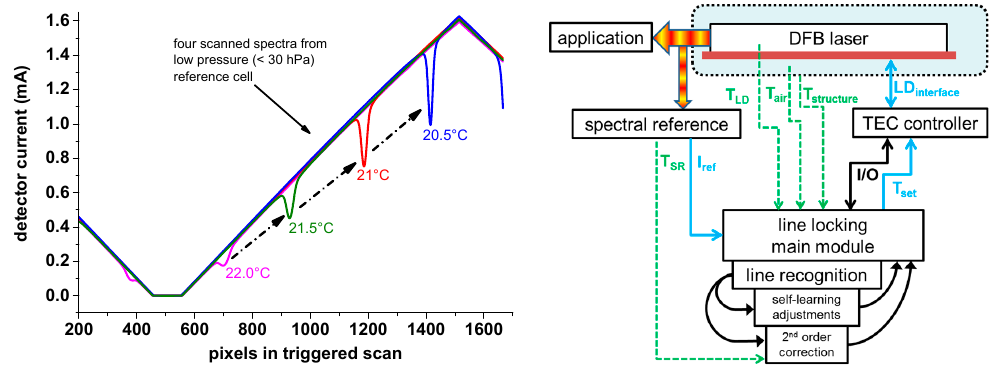
Figure 5. Left : Consequence of a diode laser chip temperature variation, demonstrated at for different, independent spectra which are combined in this figure. These spectra are acquired after the laser light transmitted a low pressure reference cell filled with a mixture of H 2 O and air (exact knowledge of the water vapor mixing ratio is not needed). The temperature variation causes a shift in the scanned wavelength range which eventually leads to a shifted line position in the spectra. Due to the nonlinear laser tuning over the spectral scan a position shift—if not corrected for—leads to a systematic H 2 O response variation of the instrument; Right : Sketch of the important modules and data flows needed for the spectral stabilization.